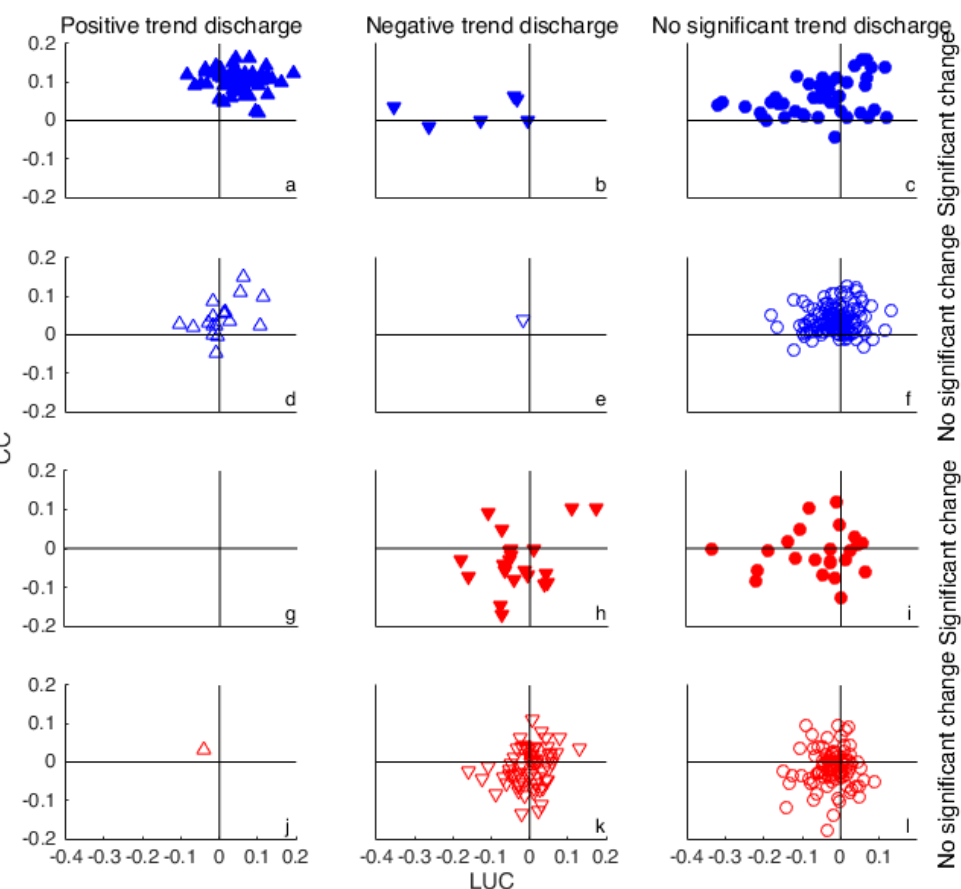
Figure 4. Contribution of land use change ( x -axis) and climate change ( y -axis) for the American (blue) and Australian (red) catchments. The first and third (second and fourth) rows include catchments with (without) significant LUC and/or CC values.